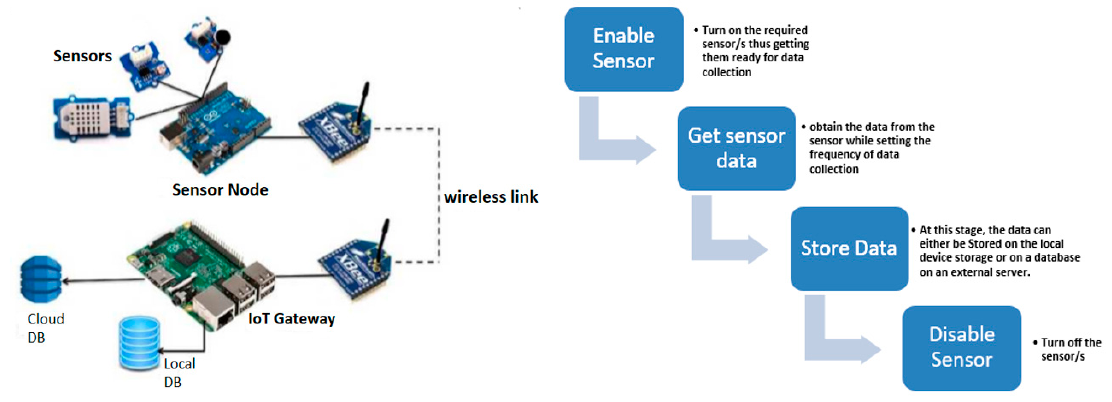
Figure 1. Traditional IoT components for deploying IoT solutions (Left). Data collection process by the SMIoT architecture (Right).